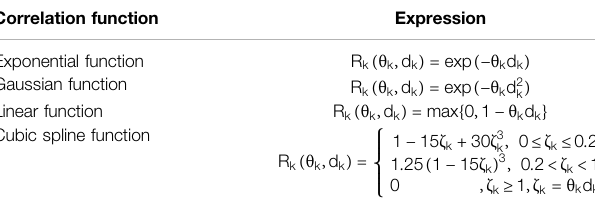
TABLE 1 | Commonly used correlation functions and their